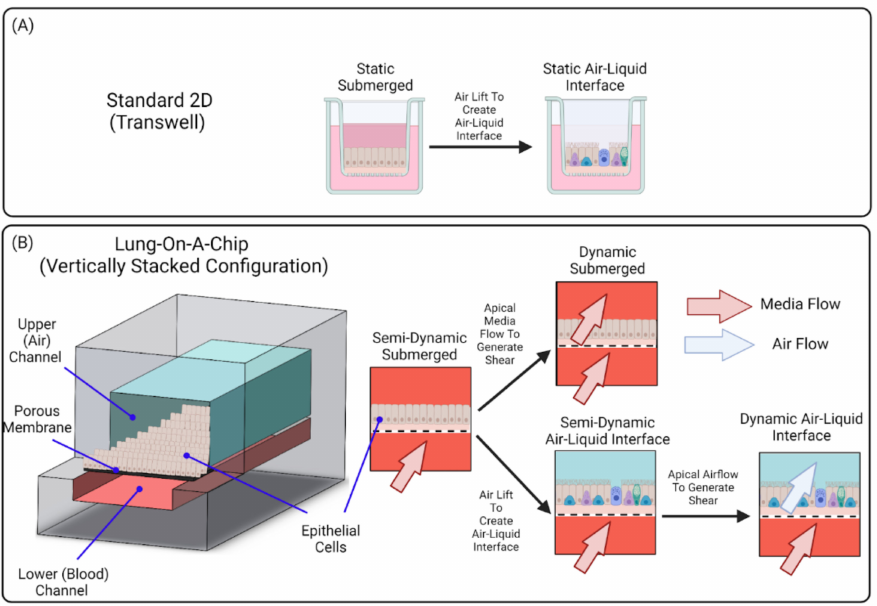
Figure 3. Air–Liquid Interface Configurations. ( A ) Standard 2D ALIs require simply removing media from the top compartment while ( B ) ALI in lung-on-a-chip devices can be operated in semi-dynamic or dynamic mode. Lung-on-a-chip platforms permit recapitulation of the flow physiology, both the blood flow in the basal compartment, as well as air flows. Lung-on-a-chip platforms can also mimic the submucosal layer. Finally, lung-on-a-chip models permit delivery of aerosols to model inhalation of droplets or particulate